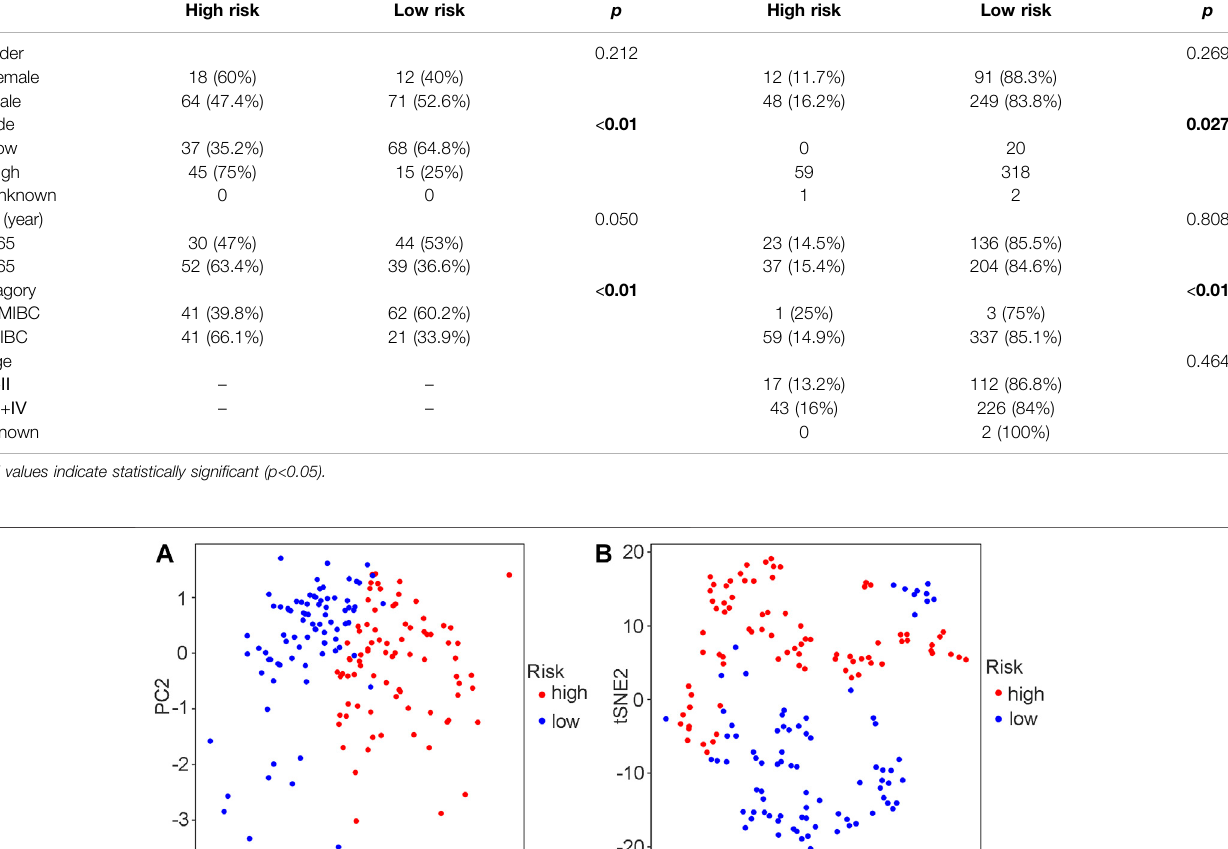
TABLE 3 | Patient characteristics in different risk groups.